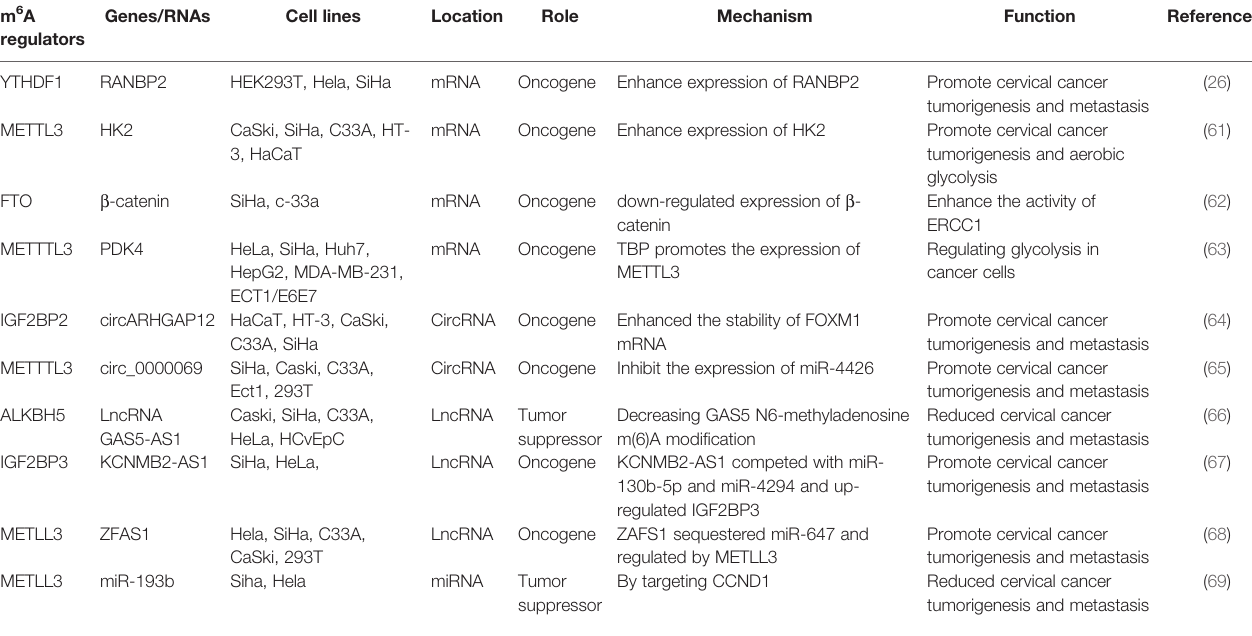
TABLE 1 | The roles of different m 6 A regulators in regulating RNAs in cervical cancer. m 6